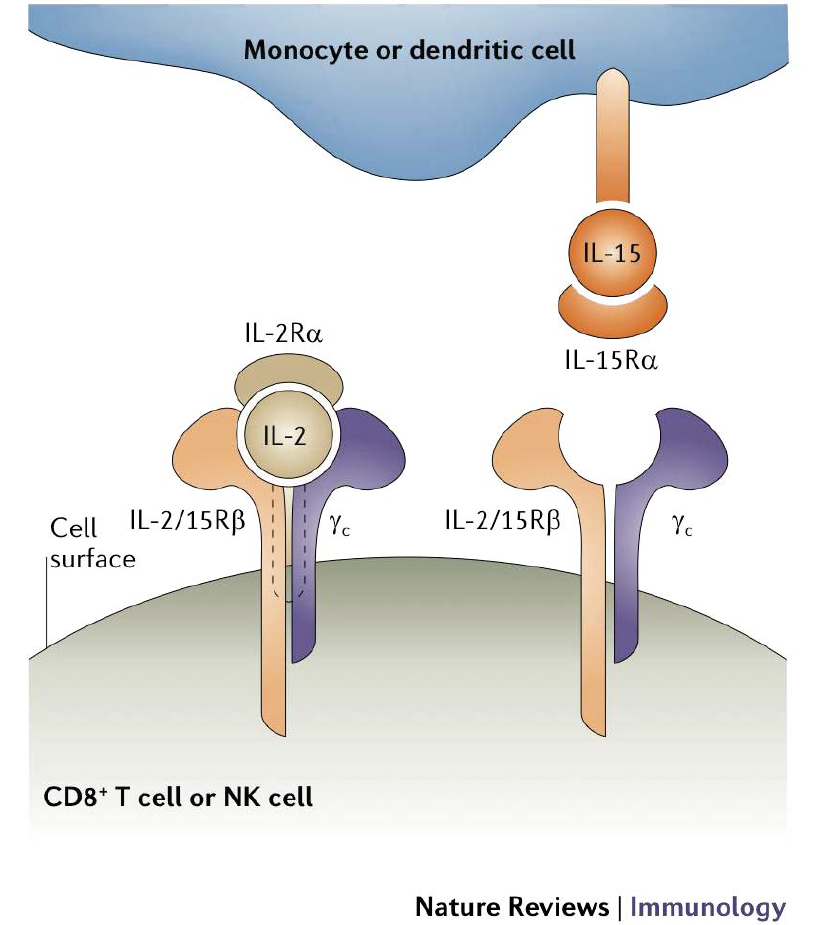
Figure 2. Structural differences in IL-2 and IL-15 signaling. IL-2 and IL-15 bind two common subunits (IL-2R/15R (cid:2) and (cid:4) ) which signal through the same JAK and STAT c molecules, accounting for the similarity in their actions. However, while IL-2 is a secreted cytokine and binds receptors on the surface of activated cells, IL-15 is primarily membrane bound and must be presented through cell-cell contact, which then involves additional costimulatory signals that further modify the cell response. Reprinted by permission from Macmillan Publishers Ltd: Nature Reviews Immunology, 2006